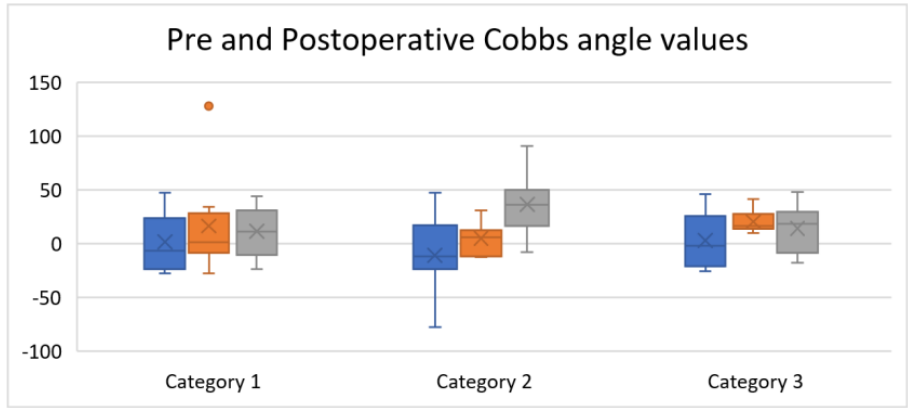
Figure 1. Comparison between the pre- and postoperative Cobb angle values. Confidence interval of 95% (CI 95%) for preoperative Cobb angle was between 57.8 – 65.9°, for postoperative Cobb angle, was between 21.8 – 28.8°, the absolute difference was between 33.9 – 39.3°, and the correction rate was between 56.1–64.1%, respectively. p -value was <0.0001. Category 1-Mean value, Category 2-Standard deviation, Category 3-CI (95%).